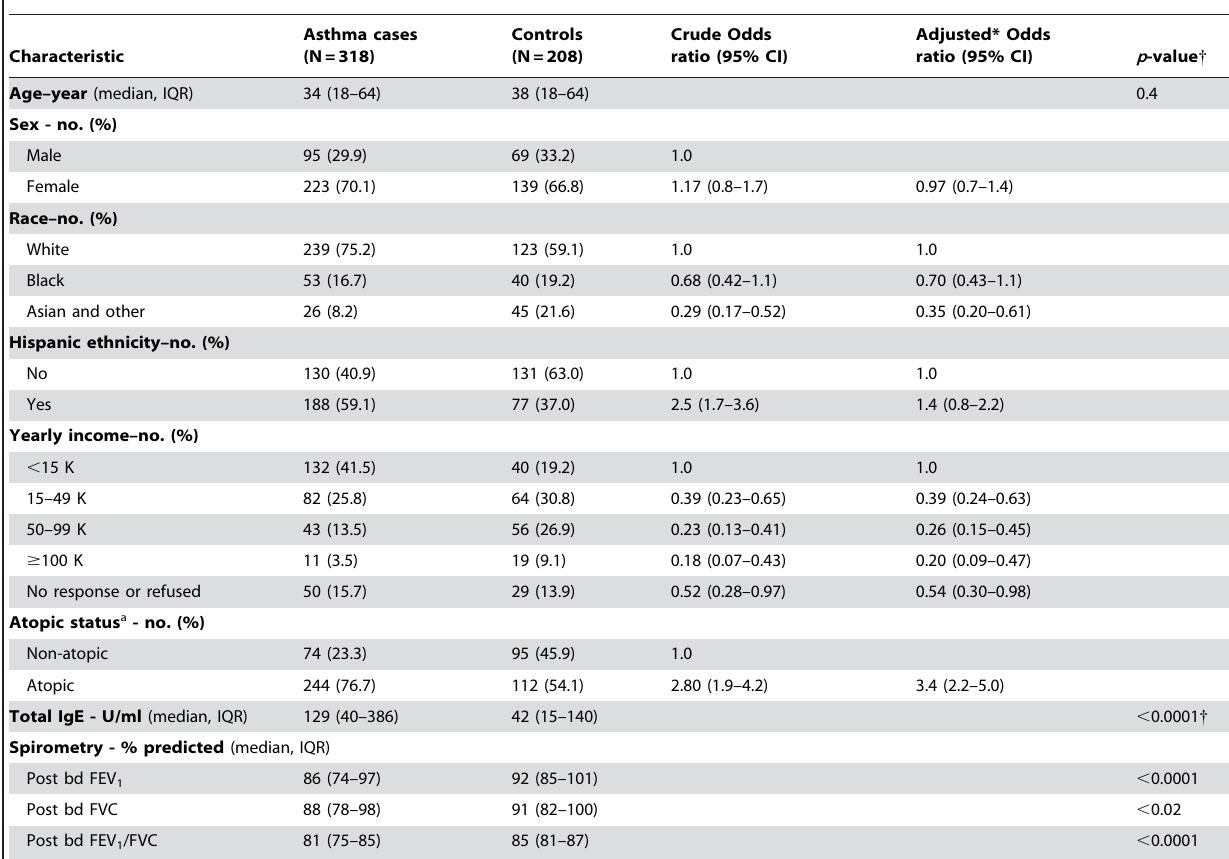
Table 1. Characteristics of the case control study